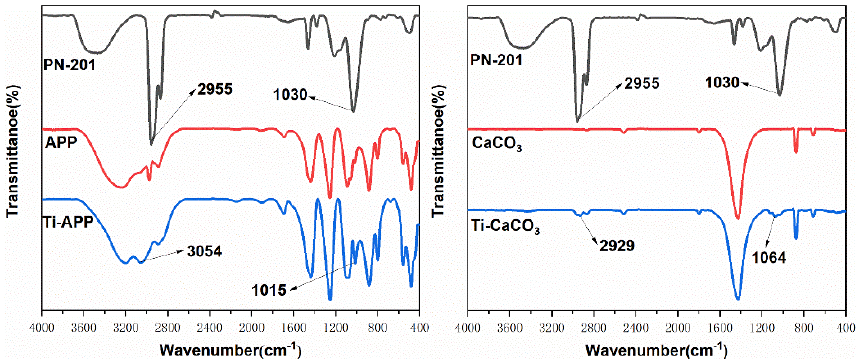
Figure 6. FTIR spectra of APP, CaCO 3 and their modification.